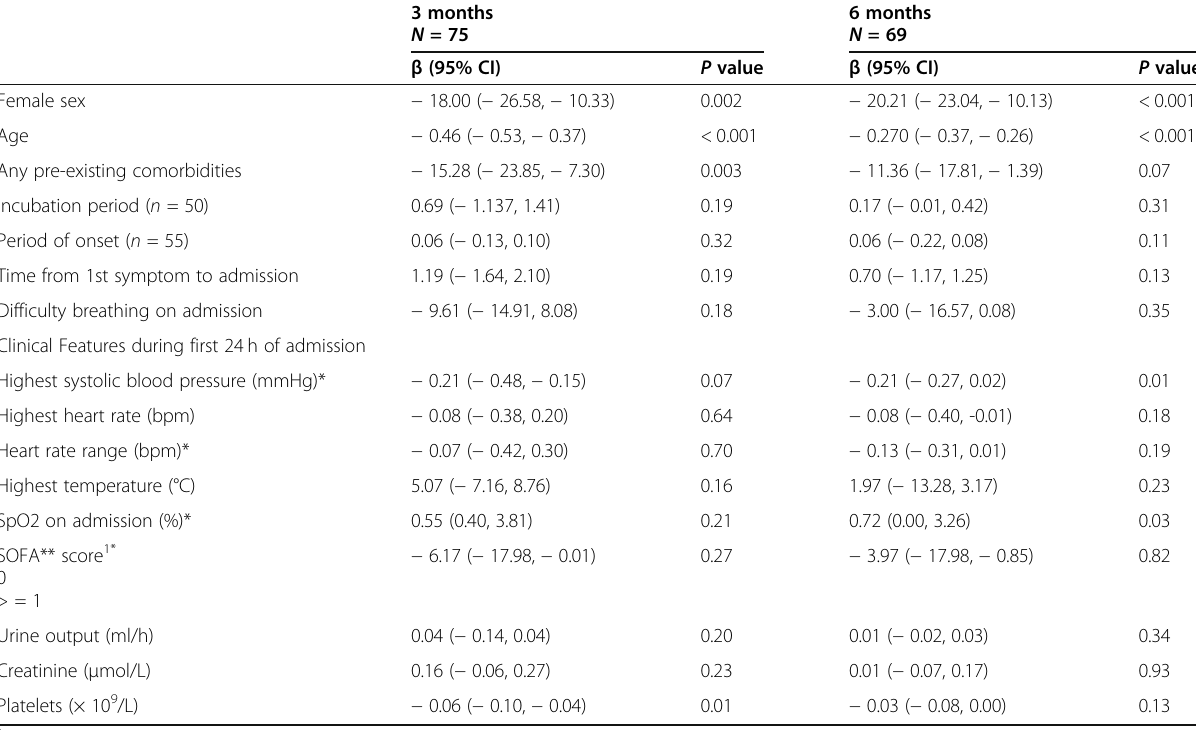
Table 4 The association between independent features on ICU admission and 25th quantile physical function at 3 months and 6